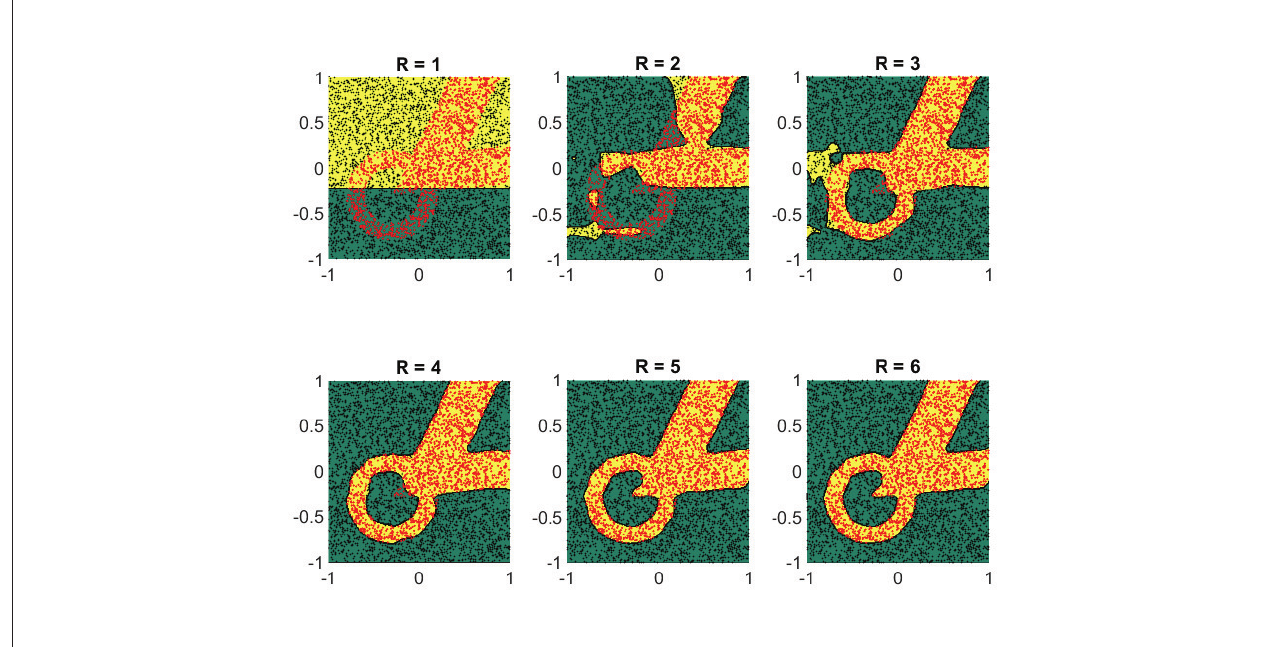
FIGURE 11 | For this particular classification set, at least five separable terms are required for a decent classification. Shown are the obtained results on a synthetic dataset by using the logistic loss function (Equation 22). The recovered classification sets are marked by the yellow and green contours, whereas the labeled data used for training are marked by red and black